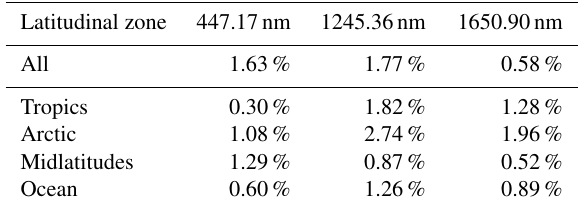
Table 3. Mean values of the distributions of TOA reflectance for each classification type, in each wavelength. The change in val- ues across this table verifies the advantage of presenting screening thresholds as a function of latitude.